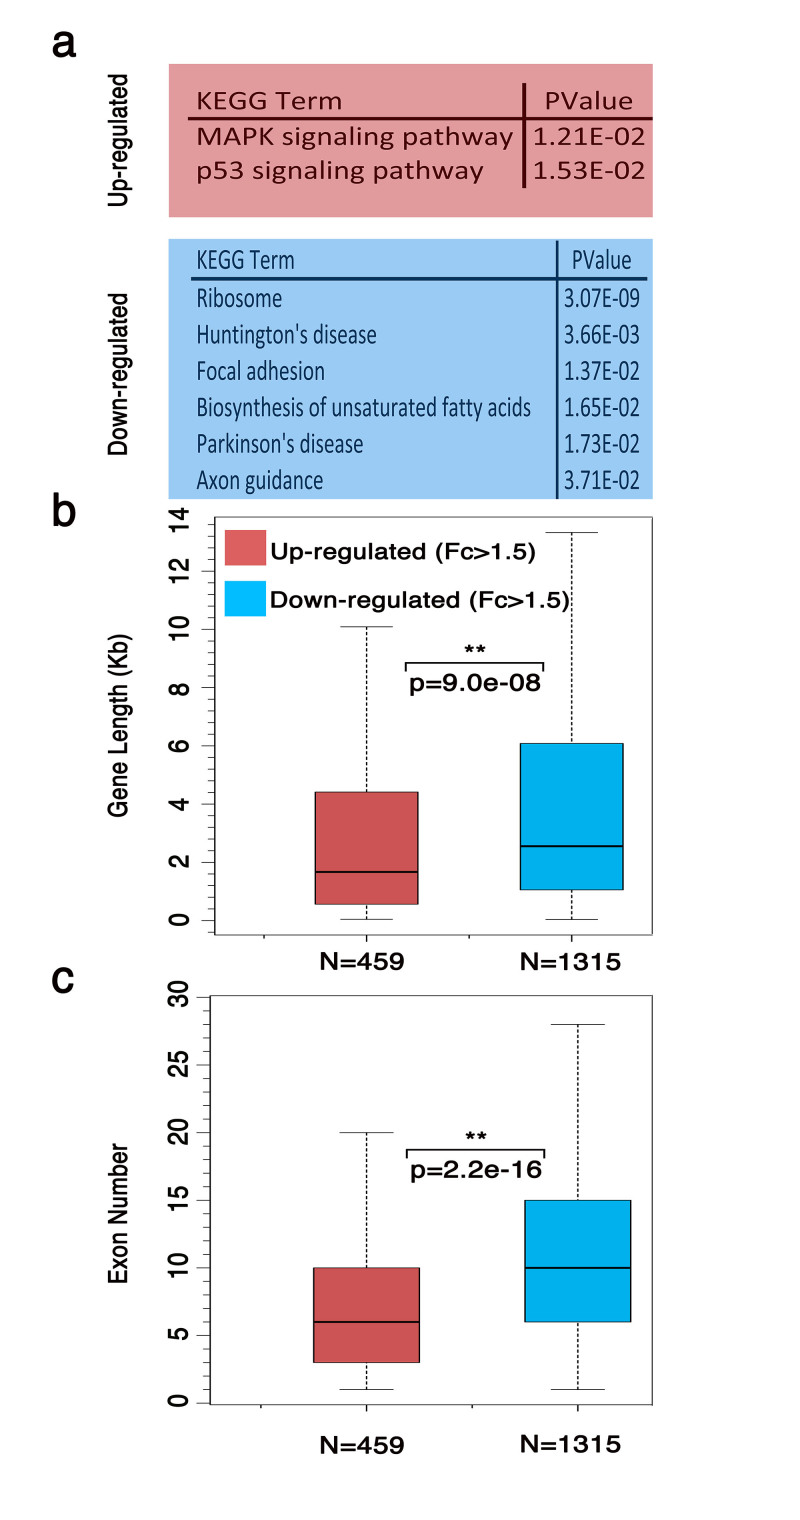
Gene structure analysis of differential expressed coding genes upon OS.(a) KEGG pathways associated with up-regulated and down-regulated coding genes in OS. Box-plot analysis of the distribution of the gene length (b) and exon number (c) of up-regulated (in red) and down-regulated (in blue) coding genes in the nucleus of both cell lines (MRC5 and BJs) and at both OS time-points (Mann–Whitney–Wilcoxon).